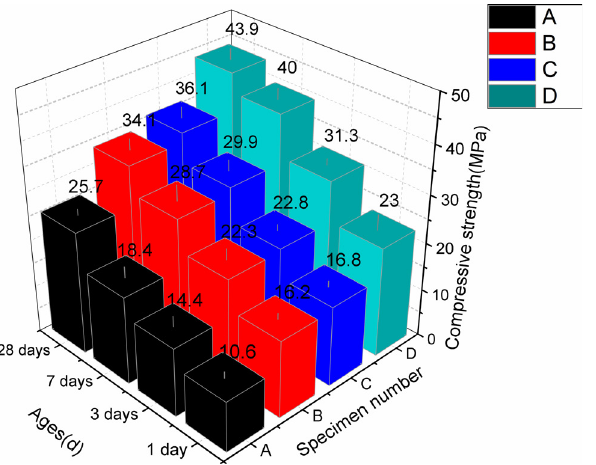
Figure 4: Compressive strength of RACs at different ages